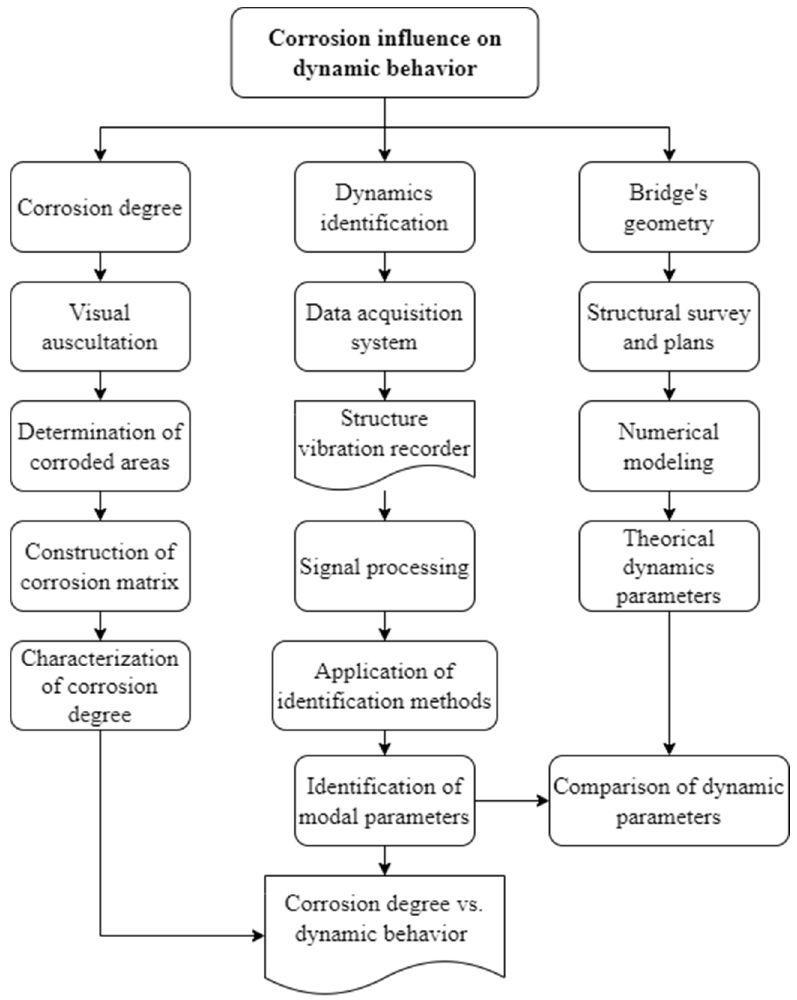
Figure 7. Flow chart—Research methodology.